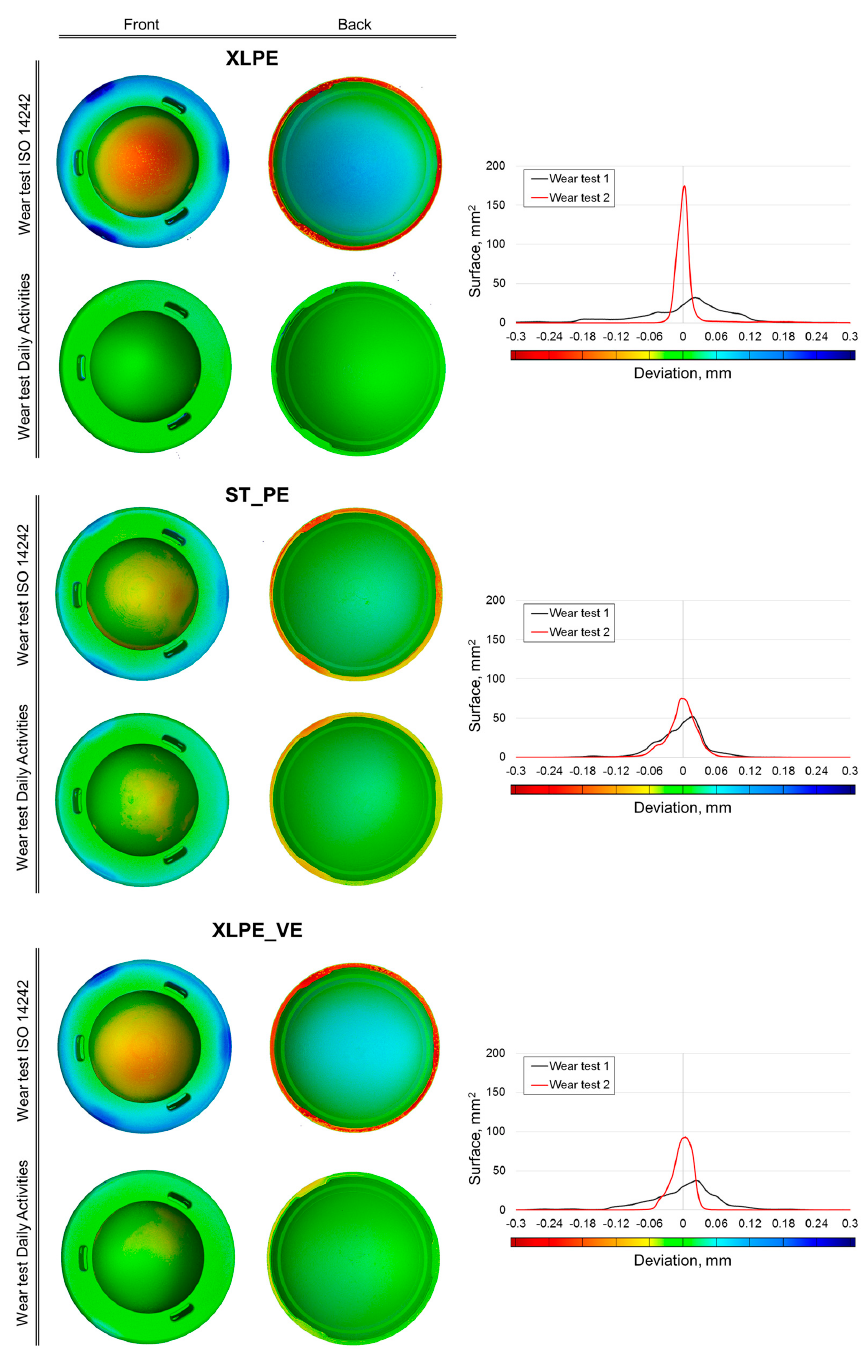
Figure 6. Comparison of deviation maps resulting from wear test under ISO 14242 and modified wear test under daily activities (one acetabular cup for each material). The range of the color scale was set between − 0.3 and 0.3 mm to include the maximum deviations. Histograms of the calculated deviations versus the entire analyzed surface of the selected object are shown. Positive deviations correspond to areas where the deformations of the component caused a raising of the material surface position, while negative deviations correspond to areas that were lowered by deformations or wear. Results obtained with the two wear tests are both illustrated considering the front side and the backside of